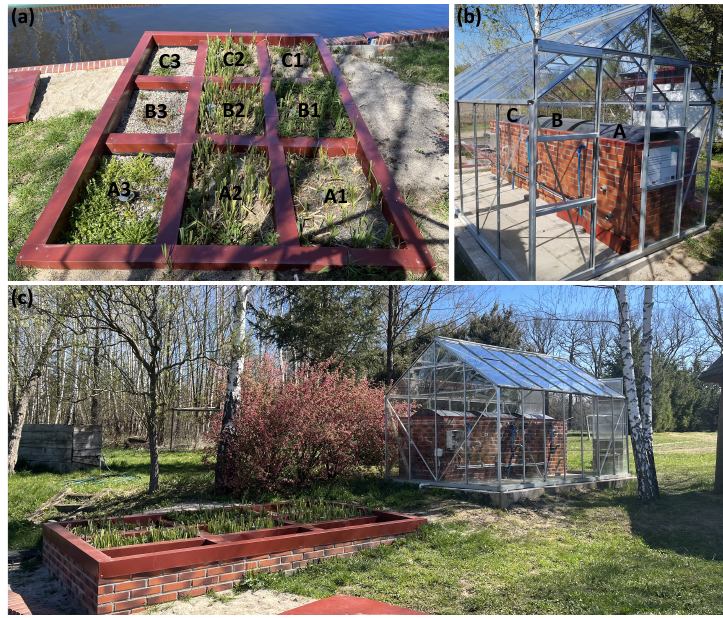
Figure 2. The pilot plant. A, B, C letters refer to the three different hydraulic loads (70, 100, and 130 l per day, respectively). ( a ) denitrification (1), phosphorus (2), and activated carbon (3) beds responsible for the water renewal, ( b ) compost beds responsible for the wastewater purification, ( c ) setting of the